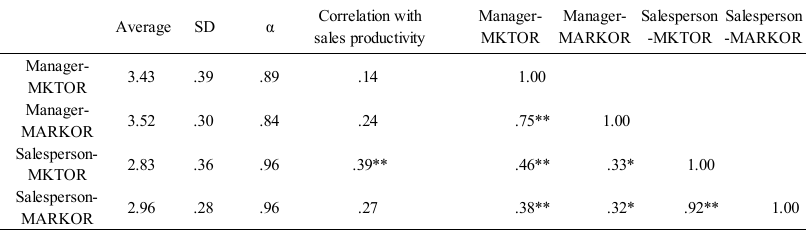
Table 1. Descriptive statistics and pairwise correlations